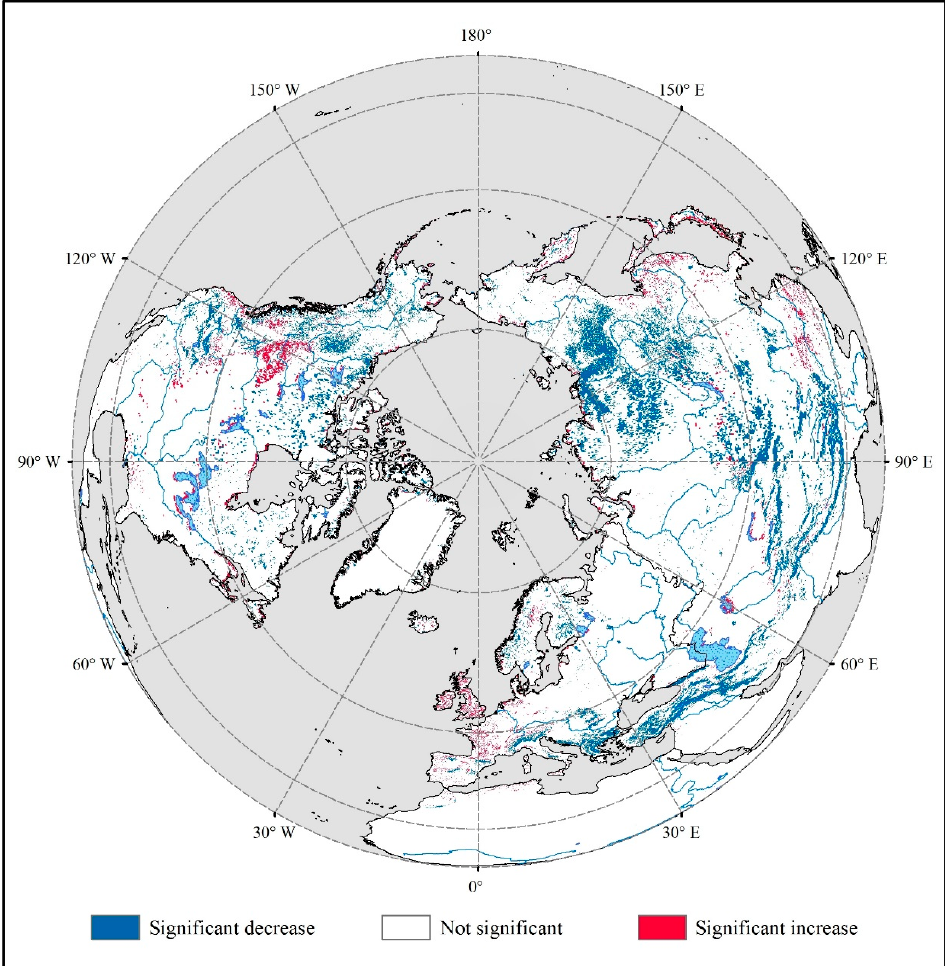
Figure 9. Significance of the variation in the annual SCDs in the Northern Hemisphere based on the Mann–Kendall method.